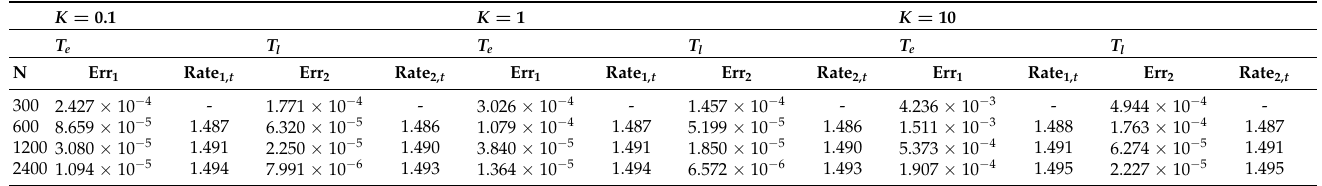
Table 3. Temporal convergence rate when M = 500 and ( α , β ) = ( 0.5,0.5 ) for Example 1.